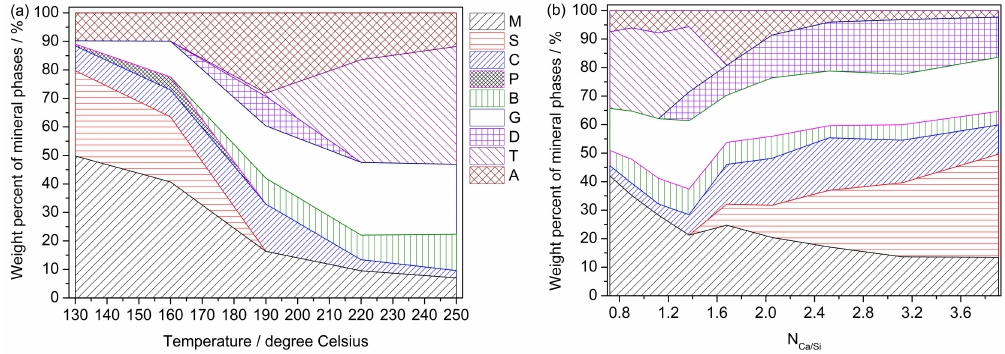
Figure 2. Results of quantitative phase analysis by the Rietveld method: ( a ) with reaction temperature; ( b ) with Ca/Si molar ratio (see the detail of the reactant ratio in Table S1).